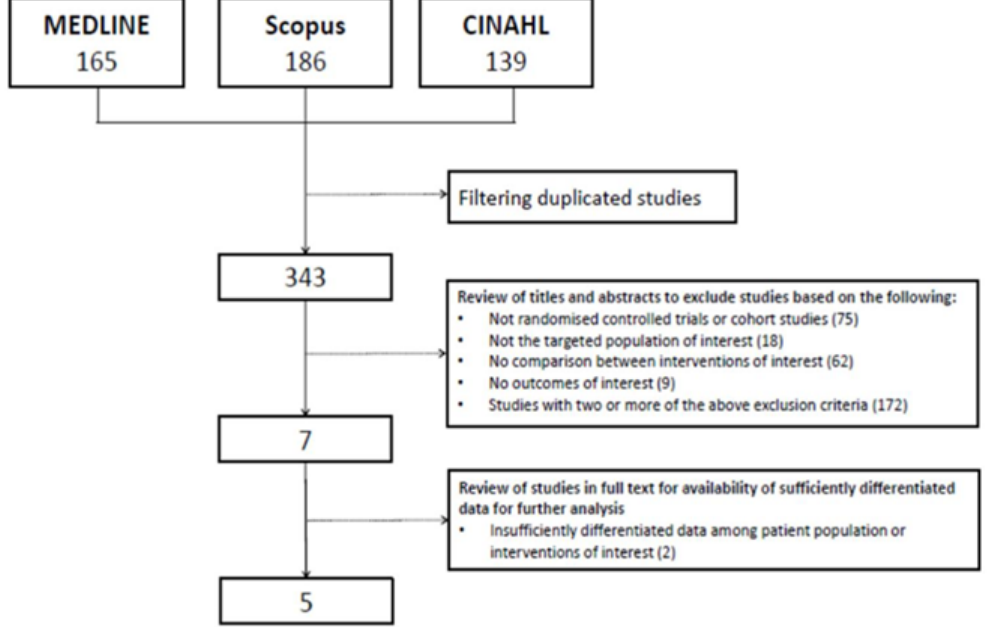
Figure 1. Search and selection process for comparison of endotracheal intubation (ETI) and supraglottic airways (SGA) patient outcomes, 2011 and 2013 updated search